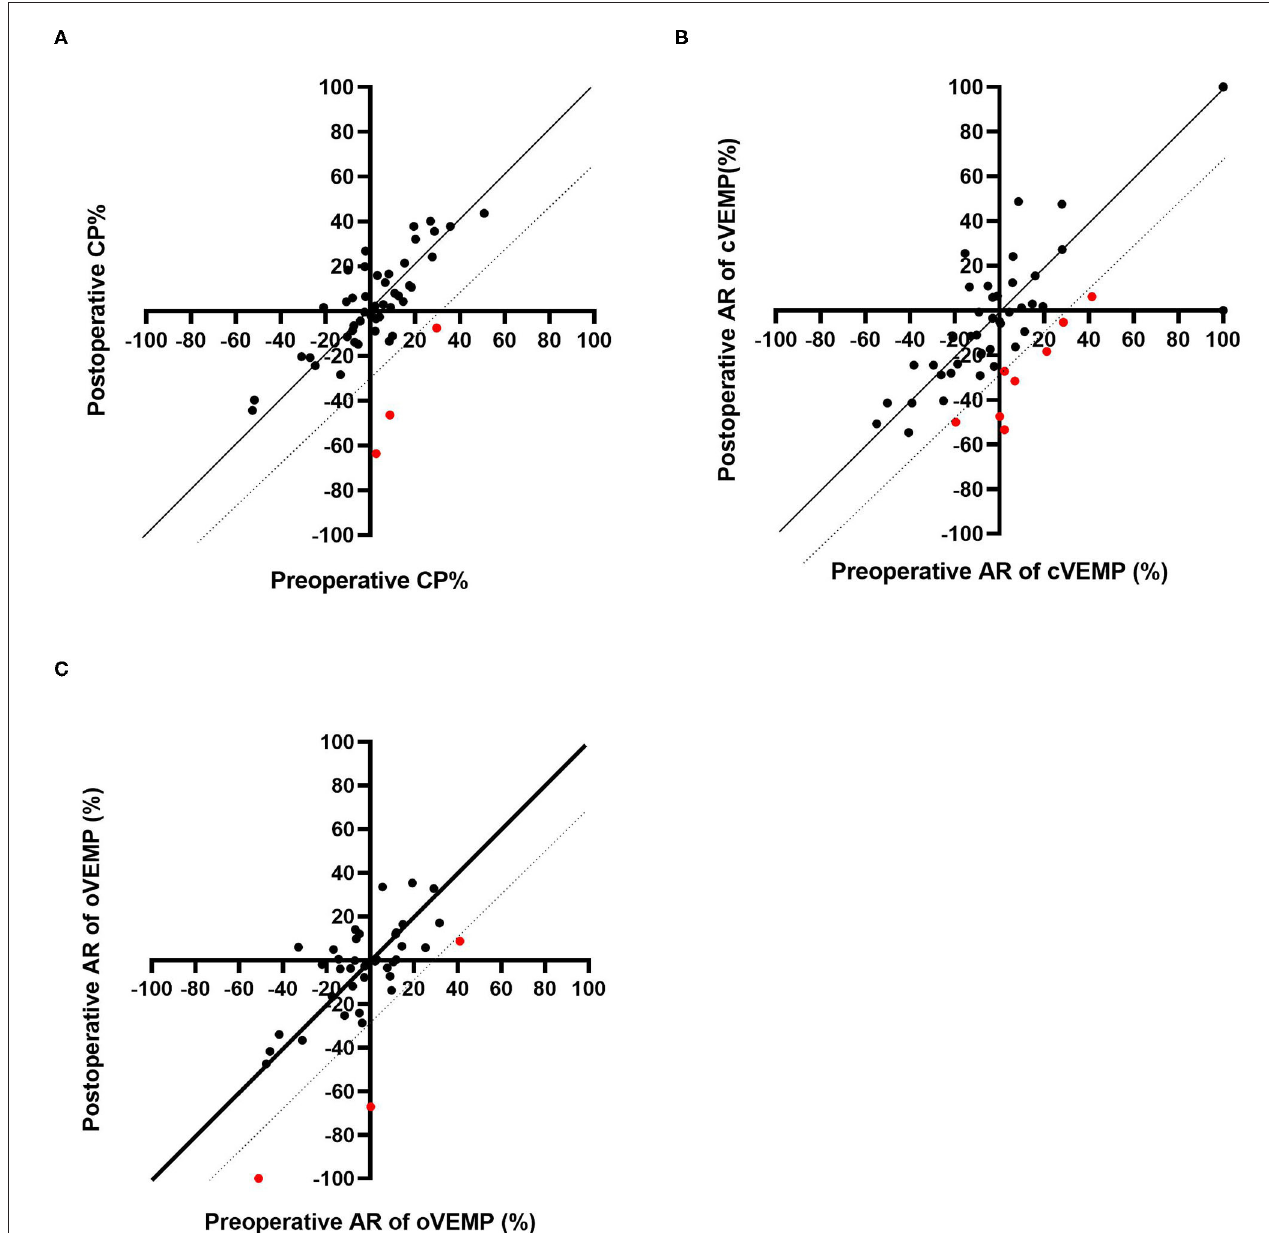
FIGURE 1 | Pre-operative and post-operative CP% based on caloric testing (A) . Pre-operative and post-operative AR based on cVEMP (B) and oVEMP (C) . The dotted line indicates the line where the post-operative result is 30% lower than that before CI. The red dots indicate the patients who showed decreased responses